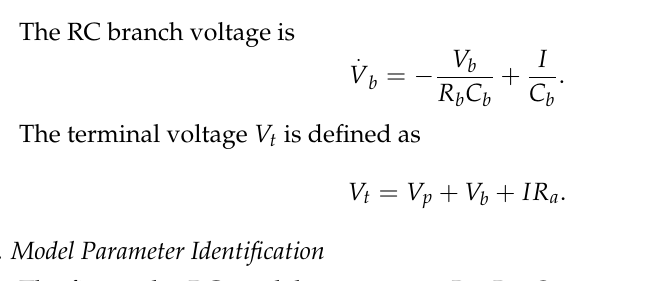
Figure 6. Thevenin equivalent battery half-cell model.